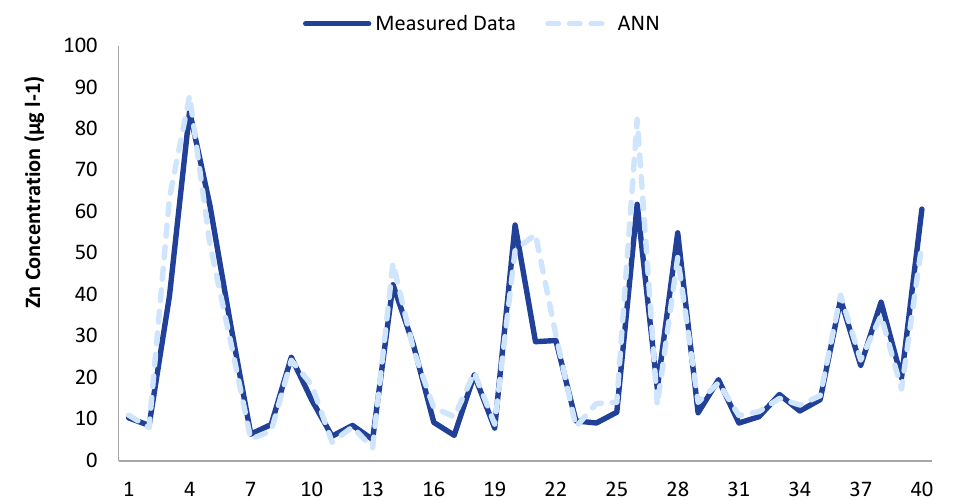
Figure 5. Comparison of the actual groundwater heavy metal concentration values and those predicted for Zn in testing phase ANN: Artificial neural